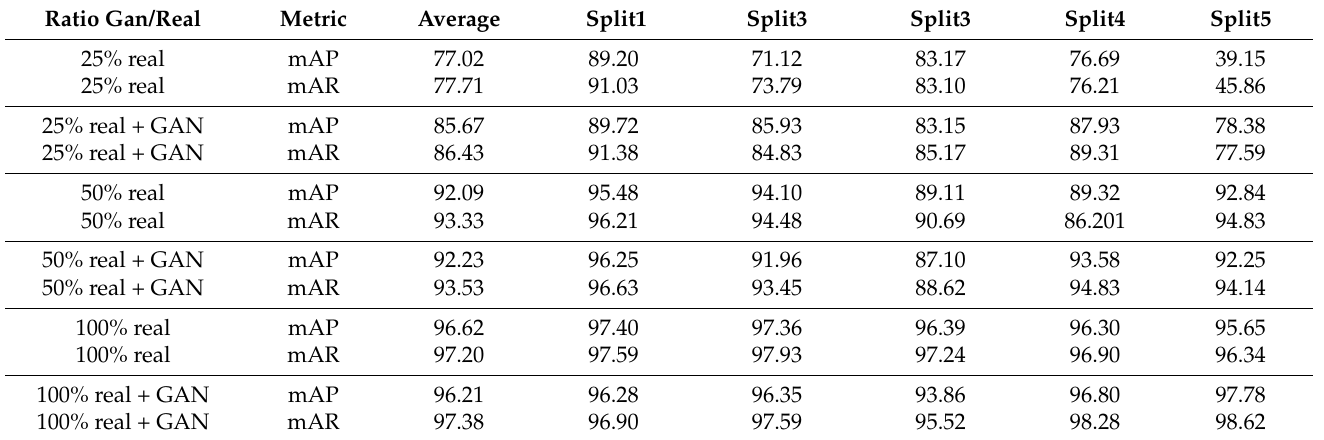
Table 1. Presented here are the results for COCO metrics mean average precision (mAP) and mean average recall (mAR) for the five different test splits and as average values. The metrics are calculated for models trained with 25%, 50% and 100% of the 204 real images (e.g., 25% real). Furthermore, the real images are combined with the synthetically created images (e.g., 25% real + GAN).